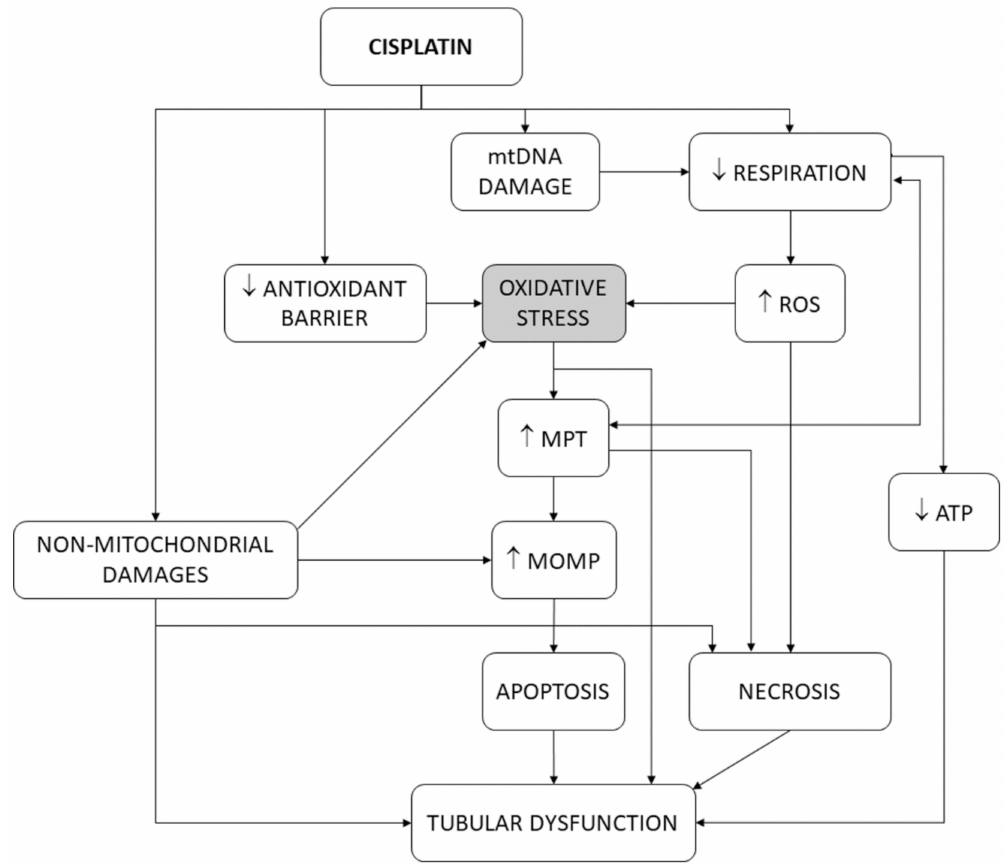
Figure 4. Schematic depiction of the pivotal role of oxidative stress in the tubular dysfunction induced by cisplatin. ATP, adenosine triphosphate. MOMP, mitochondrial outer membrane permeability. MPT, mitochondrial permeability transition. mtDNA, mitochondrial DNA. ROS, reactive oxygen